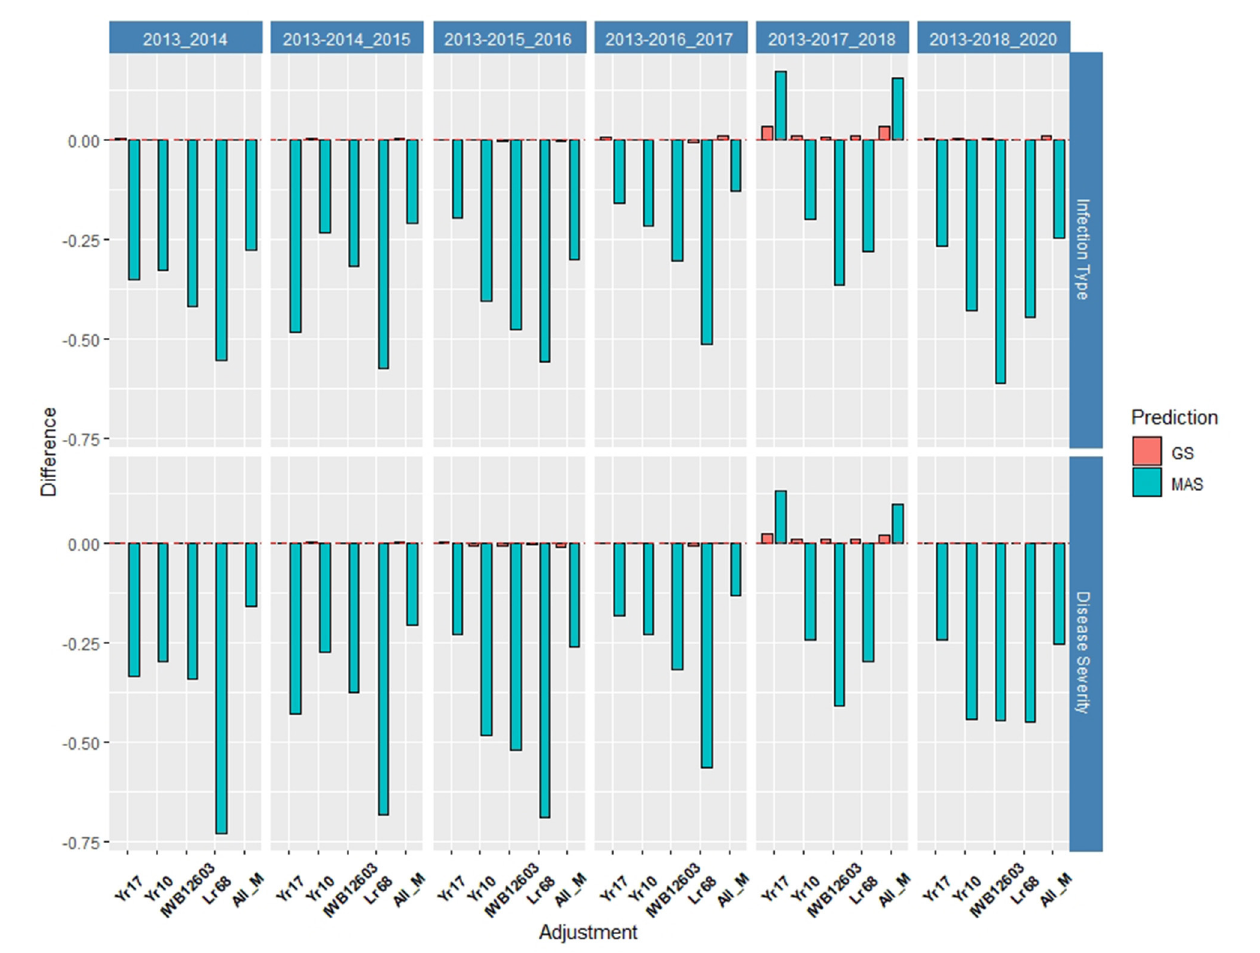
FIGURE 8 | Difference in prediction accuracy from the base rrBLUP model for major markers in GS and MAS in the validation set using the diversity panel (DP) lines and breeding lines (BL) phenotyped from 2013 to predict 2020. Adjustments: ALL_M, IWB12603(Qyr.wpg-1B.1), KASP(Lr68), Xpsp3000(Yr10), and KASP(Yr17)